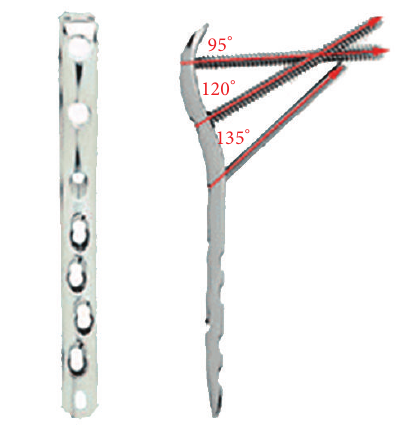
Figure 3: LCP locking plate.